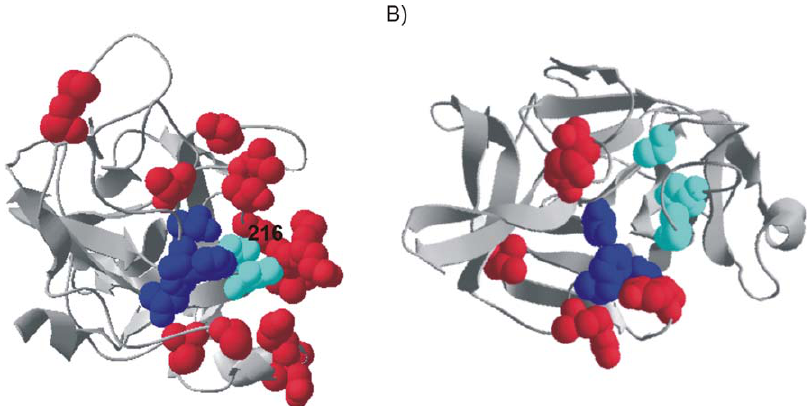
Figure 5. Structural Models Generated in SWISS-MODEL (A) protease gene family 1and (B) protease gene family 2. The blue amino acids comprise the catalytic triad of the active site. The aquamarine amino acids are determinants of substrate specificity [48]. The red amino acids indicate positively selected sites. The labeled amino acid in (A), 216, is a positively selected amino acid that is also a determinant of substrate specificity. doi:10.1371/journal.pgen.0030148.g005 PLoS Genetics |